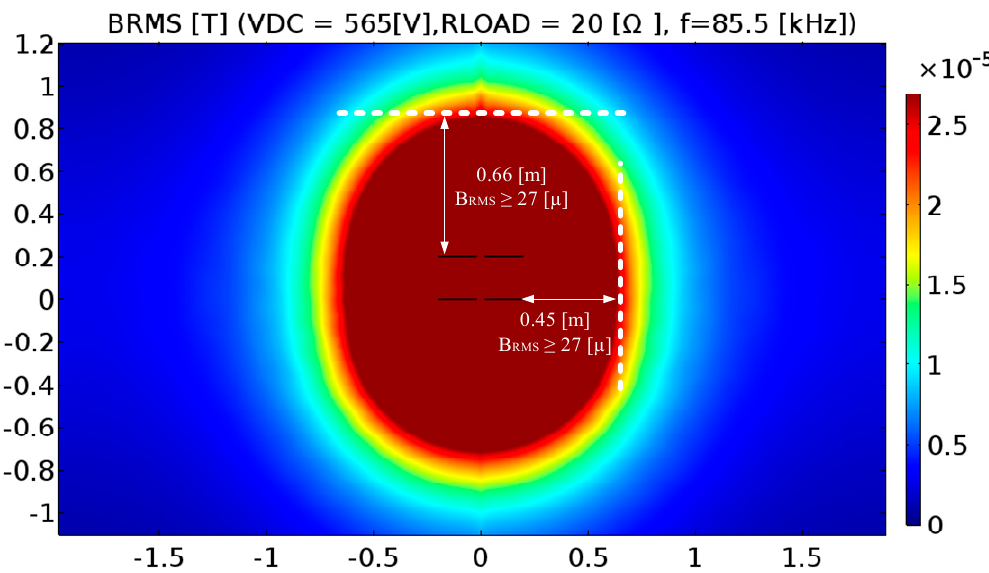
Figure 15. The distribution of the magnetic flux density of the Non-Shielded WChS.